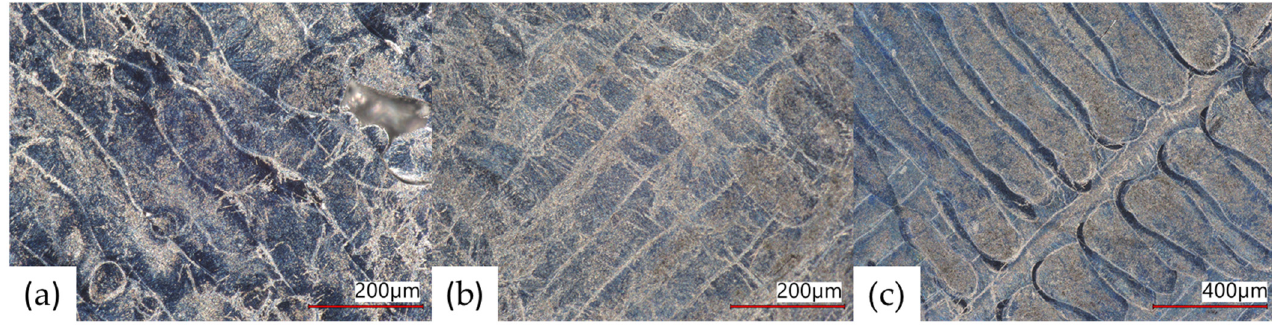
Figure 20. Microscopic images of the polished surfaces of ( a ) low LED test piece (0.23 J/mm), ( b ) Reference LED test piece (0.33 J/mm) and ( c ) high LED test piece (0.50 J/mm).